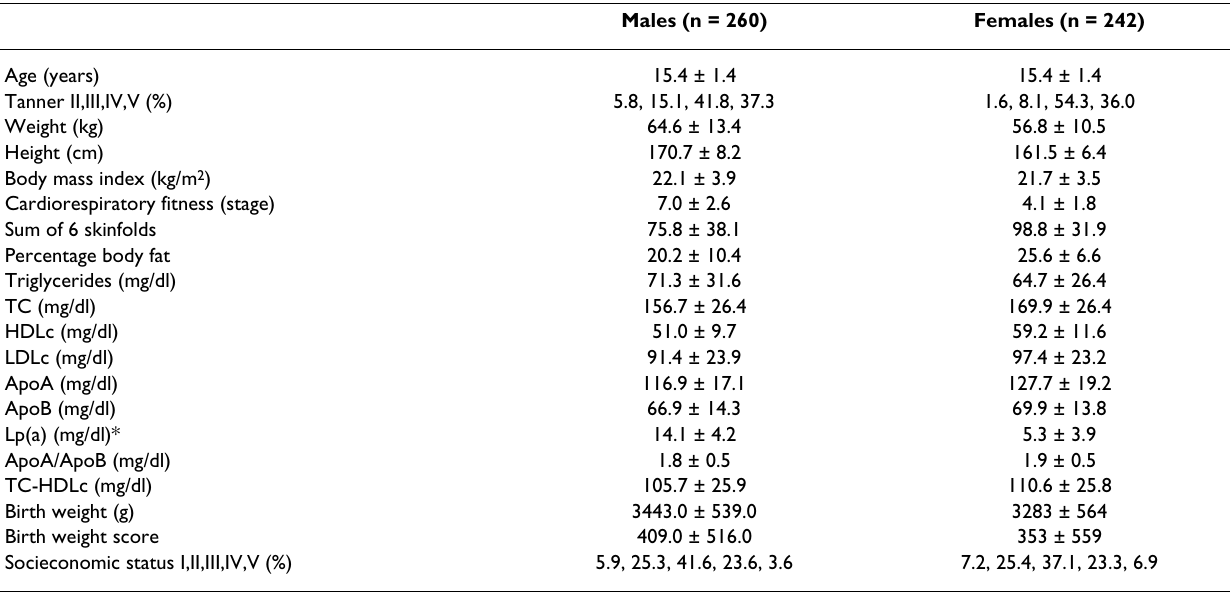
Table 1: Descriptive characteristics of the study